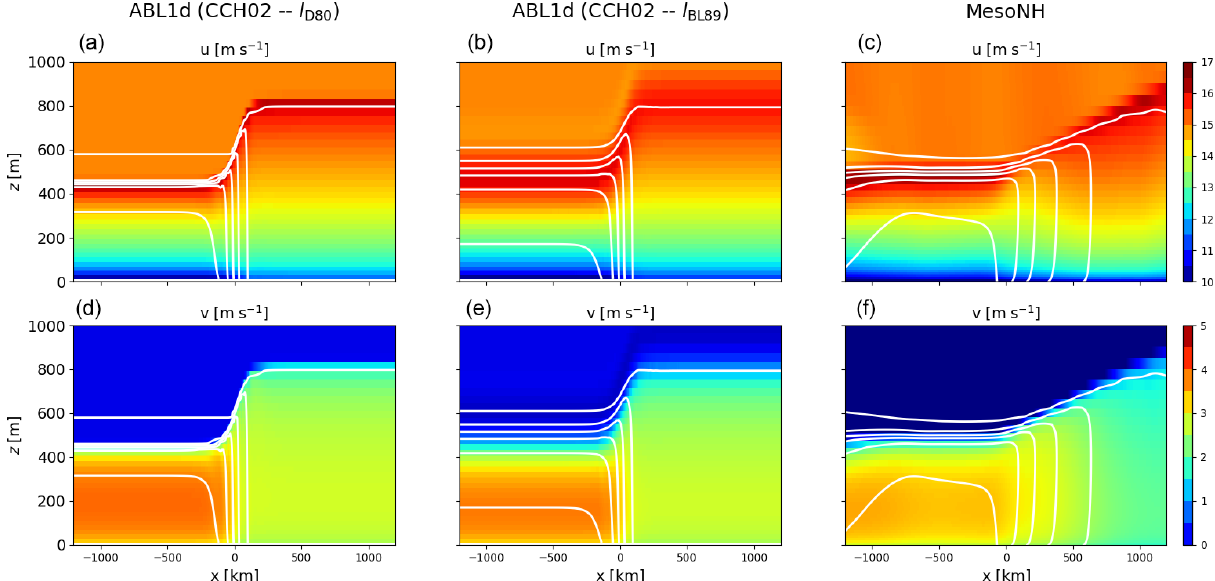
Figure 6. Zonal (a, b, c) and meridional (d, e, f) components of atmospheric winds for the reference MesoNH simulation (c, f) , for ABL1d simulations with l D80 mixing length and CCH02 model constants (a, d) , and with l BL89 mixing length and CCH02 model constants (b, e) . Temperature contours are shown in white with a contour every 0 . 5 ◦ C between 15 and 17 . 5 ◦ C. The SST front is centered at x = 0km.